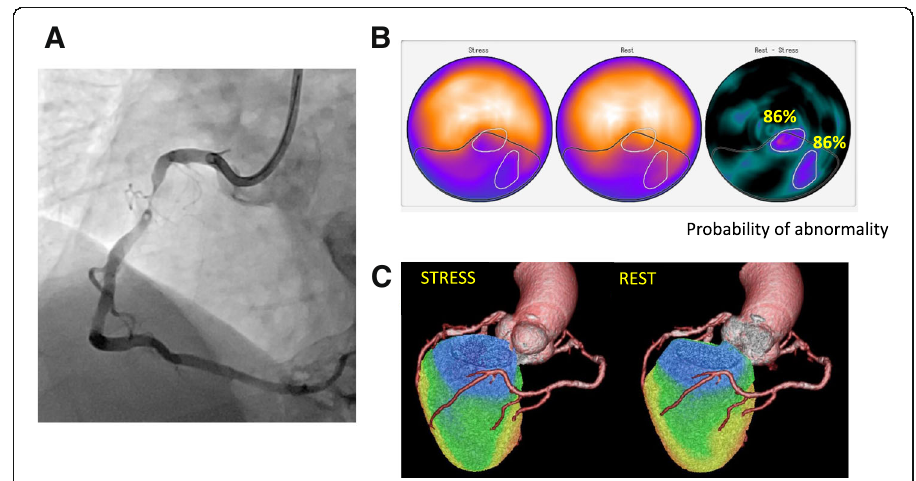
Fig. 6 Highest stress defect score and ischemia determined by ANN and two observers in 79-year-old man with angina pectoris. Coronary angiography revealed 90% stenosis in RCA ( a ). Consensus interpretation diagnosed stress-induced ischemia and infarct in the inferior walls. Defect SSS, SRS, and SDS were 11, 6, and 5, respectively. Artificial neural network detected abnormality in inferior regions under stress-induced ischemia (black contour, ANN probability: 0.97) and ischemia (white contour, ANN probability: 0.86) images ( b ). Hybrid images of CCTA and myocardial perfusion SPECT identify culprit as RCA ( c ). ANN artificial neural network, CAG coronary angiography, LAD left anterior descending coronary artery, RCA right coronary artery, SDS summed difference score, SRS summed rest score, SSS summed stress